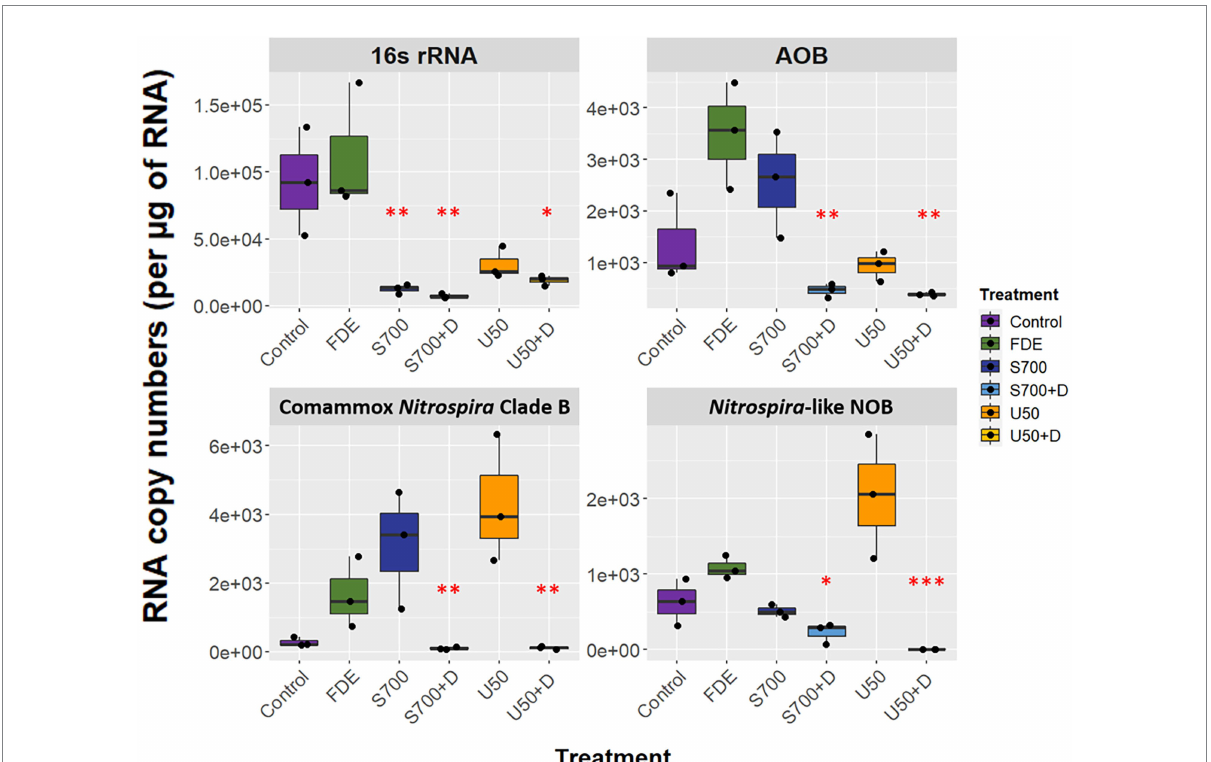
FIGURE 3 Functional gene expression of the microcosm study at day 58. RNA copy numbers of 16S rRNA, amoA of AOB and comammox Nitrospira Clade B, and nxrB of Nitrospira -like NOB at day 58 of the macrocosm study ( n = 3). Box plot whiskers bar indicates variabilities of maximum upper and lower quartiles. One-way analysis of variance (ANOVA) was used to calculate significant differences between treatments (* p < 0.05, ** p < 0.01, *** p <